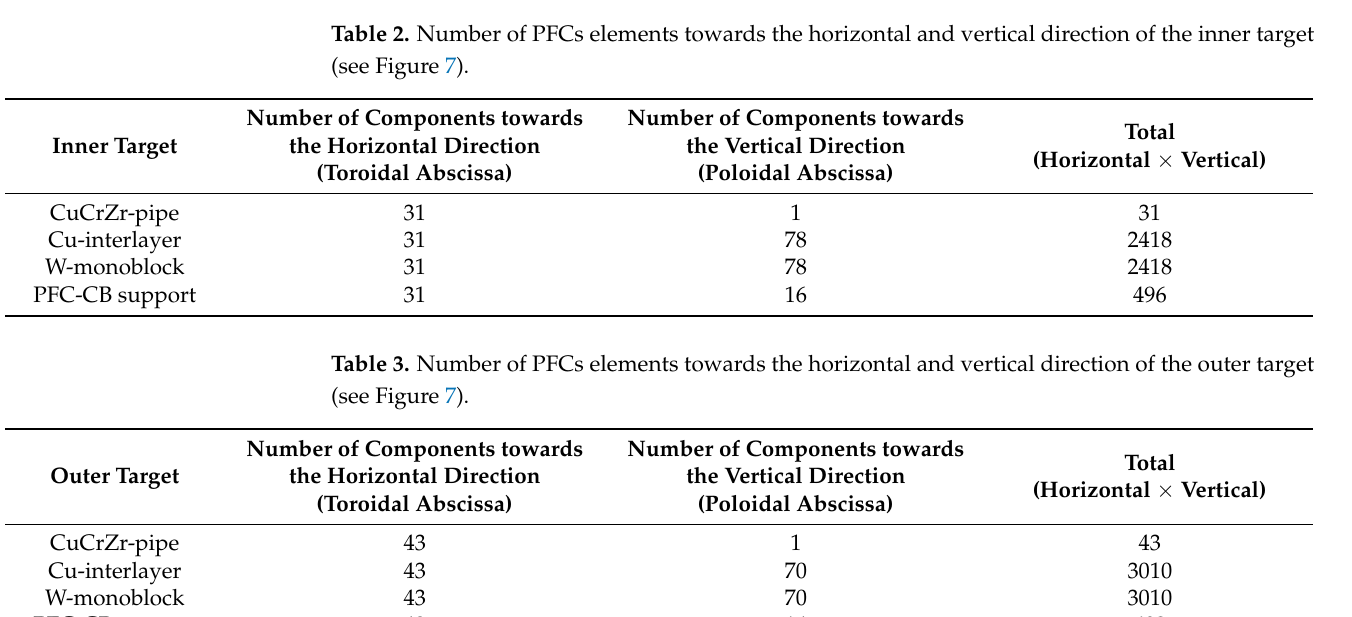
Table 3. Number of PFCs elements towards the horizontal and vertical direction of the outer target (see Figure 7).